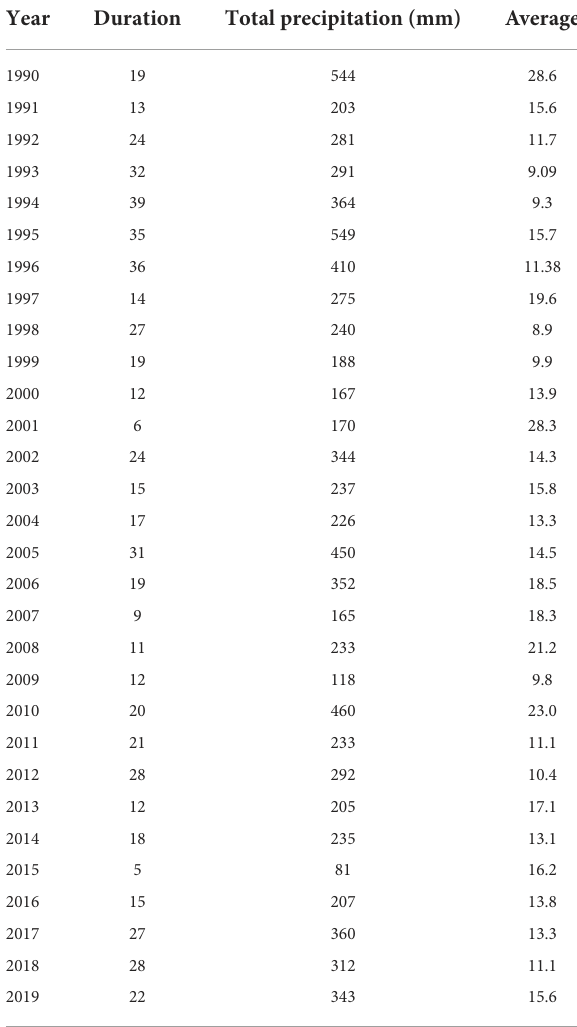
TABLE 2 The average intensity of precipitation during the first rainy